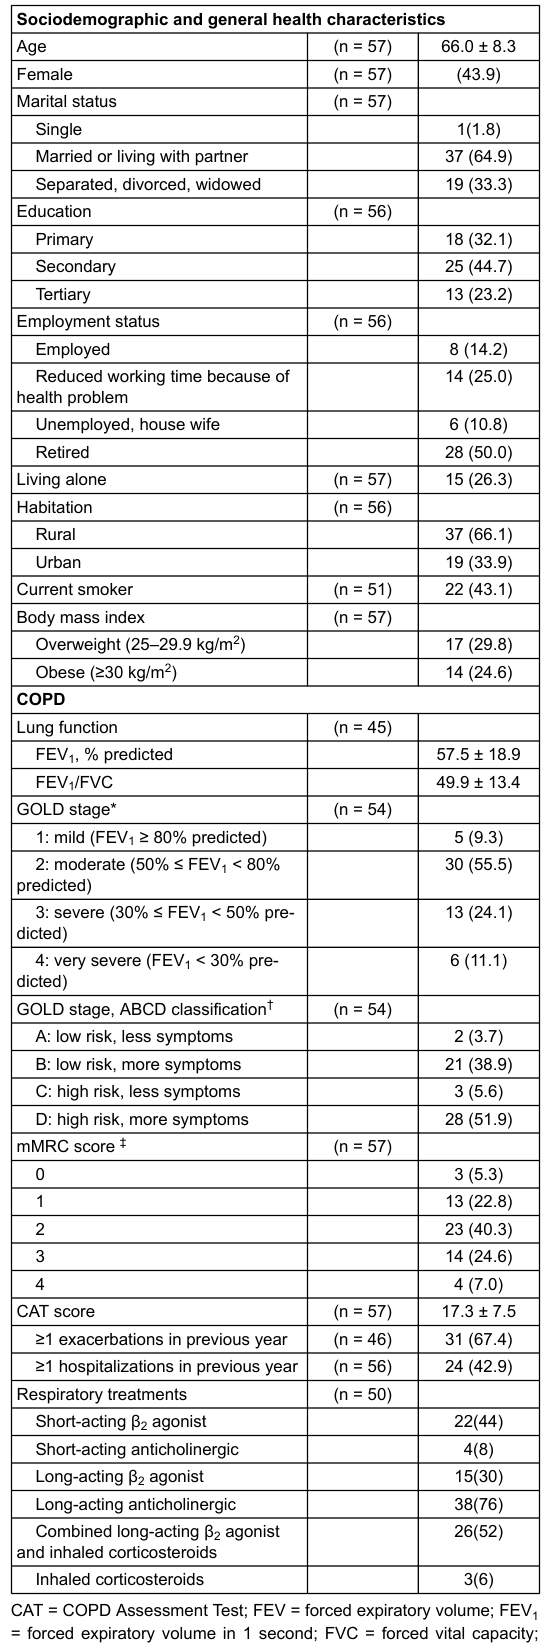
Table 1: Baseline characteristics of participants (n = 57 patients with COPD). Sociodemographic and general health